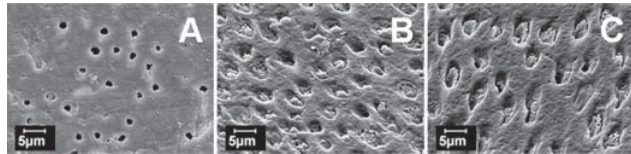
Figure 4- Scanning electron micrographs of sclerotic dentin (A - with no treatment) and after phosphoric acid etching (B and C). In B: sclerotic dentin treated with phosphoric acid for 15 s and in C for 30 s. The number of exposed tubules in B and C is higher than A and similar between them